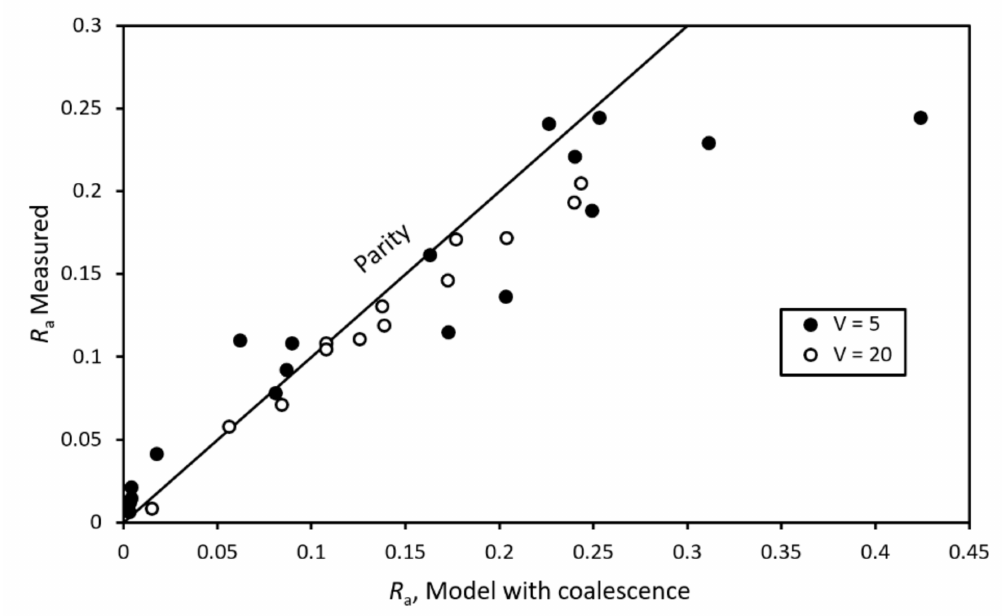
Figure 10. Measured adsorptive recovery vs. modeled adsorptive recovery (taking into account measured bubble size change due to